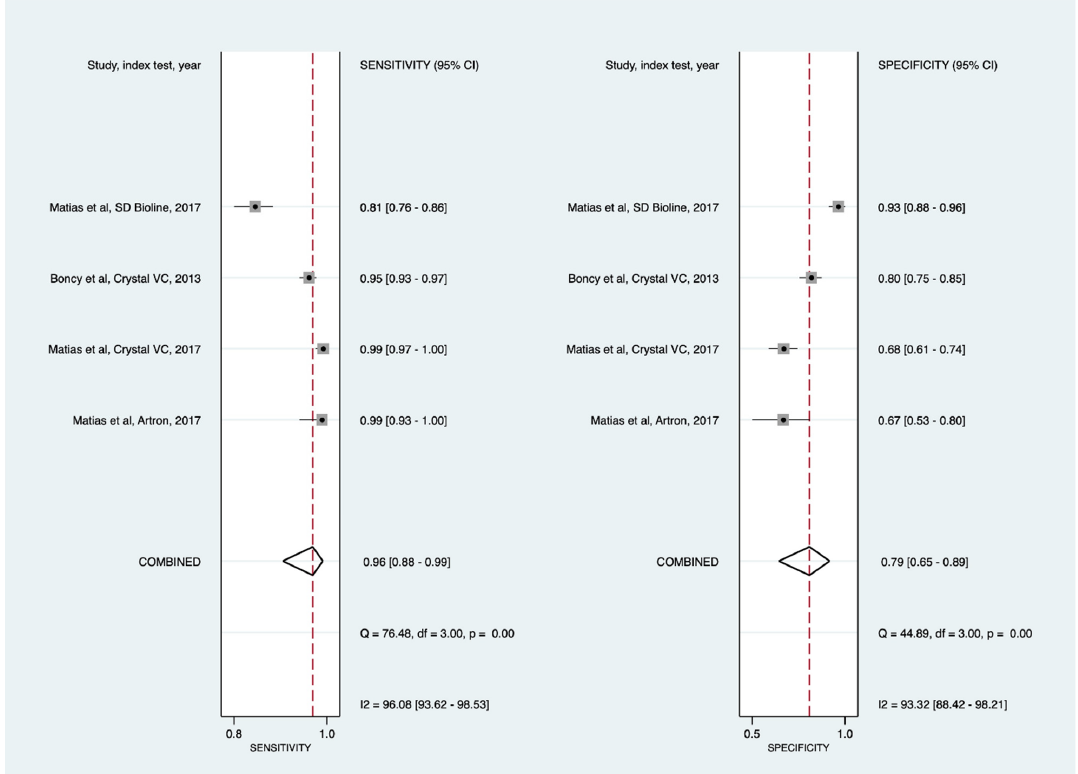
Figure 6. Forest plots of the sensitivities and specificities of cholera rapid diagnostic tests (direct stool testing) with their 95% confidence intervals. This subanalysis was restricted to studies conducted in the Americas (Haiti). CI = confidence interval.